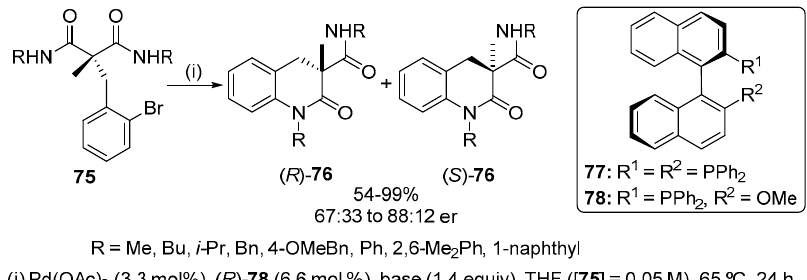
Scheme 23. Synthesis of enantiopure 3,4-dihydroquinolin-2(1 H )-ones 76 by an enantioselective Buchwald-Hartwig reaction [43].